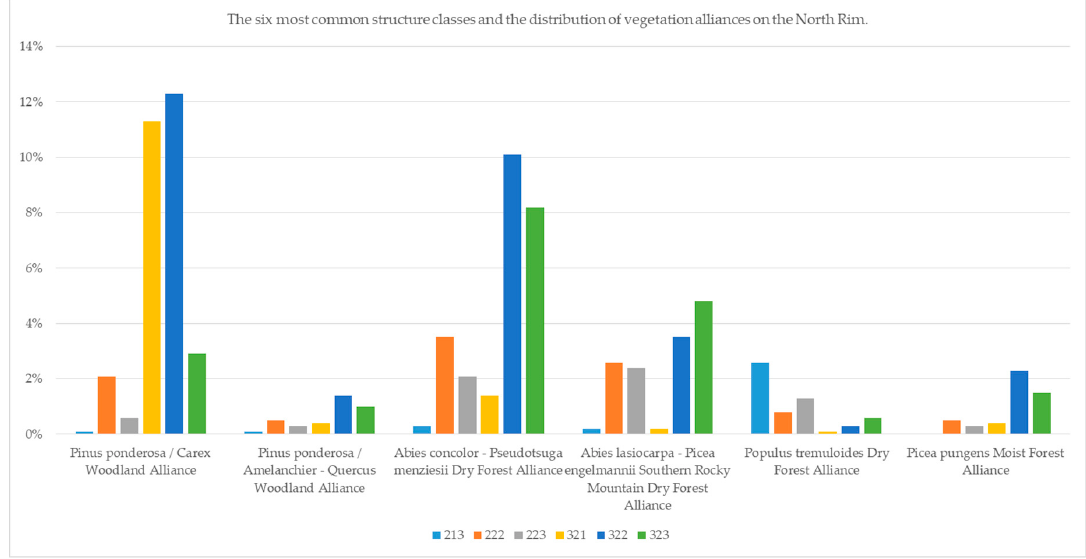
Figure 3. The six most common structure classes and the distribution of vegetation alliances on the North Rim.